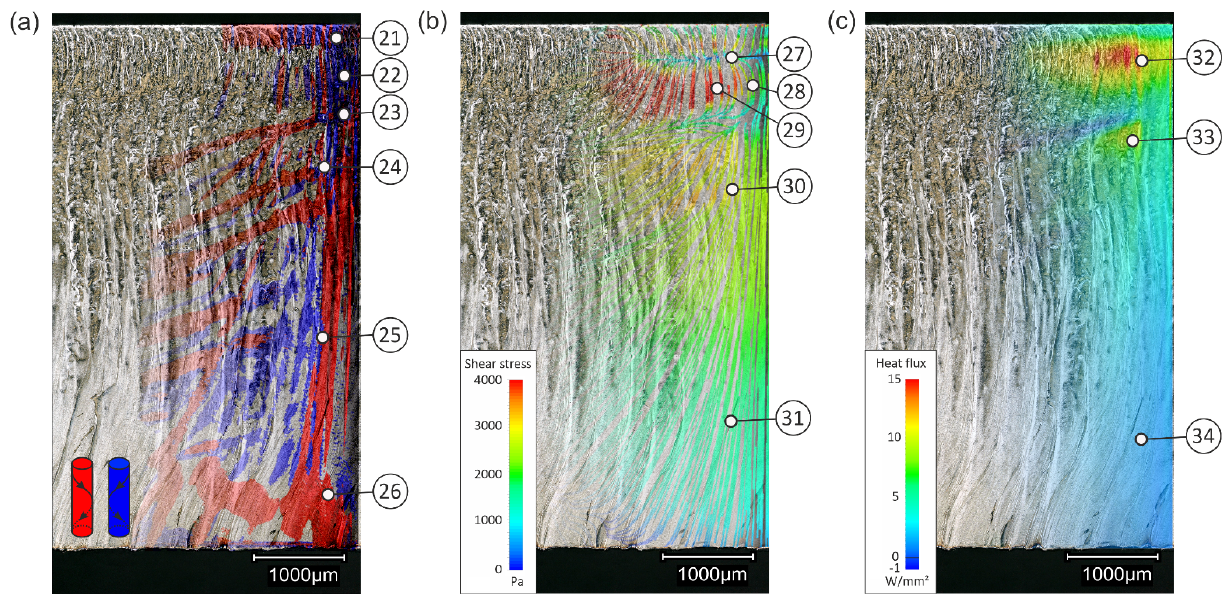
Figure 7. Typical high quality cut edge in 6 mm stainless steel separated by a 4 kW fiber laser at a cutting velocity of 4.5 m/min overlaid with ( a ) boundary layer vortex topography, ( b ) wall shear lines, ( c ) local heat flux density.